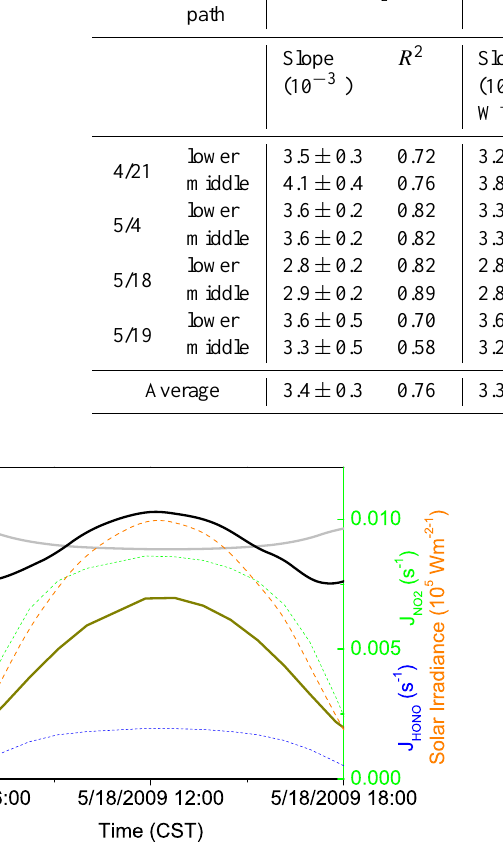
Fig. 9. Timeseries of solar irradiance, J NO of solar irradiance/ J NO May 2009, a clear and sunny day.